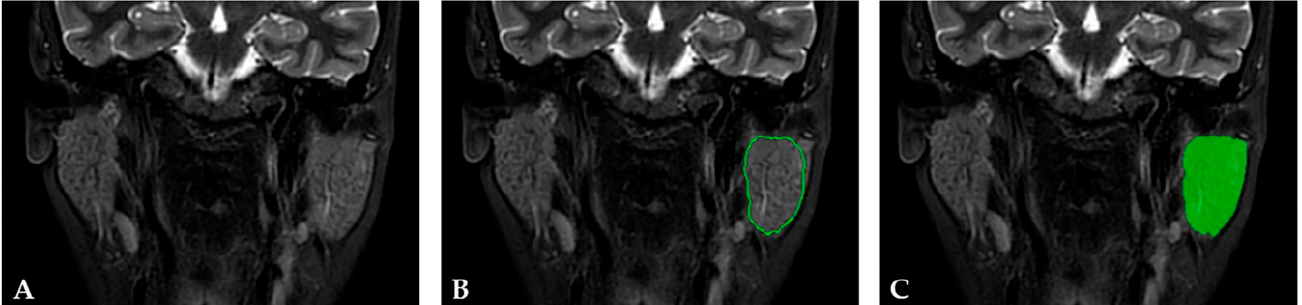
Figure 1. ( A ) MRI coronal STIR PROPELLER sequence of a 57-year-old female patient diagnosed with primary Sjögren’s syndrome. ( B ) The region of interest (ROI) covering almost the entire parotid gland was semiautomatically delineated by the software following geometry and gradient coordinates (green circle). ( C ) The final ROI after the manual correction was performed (green area).